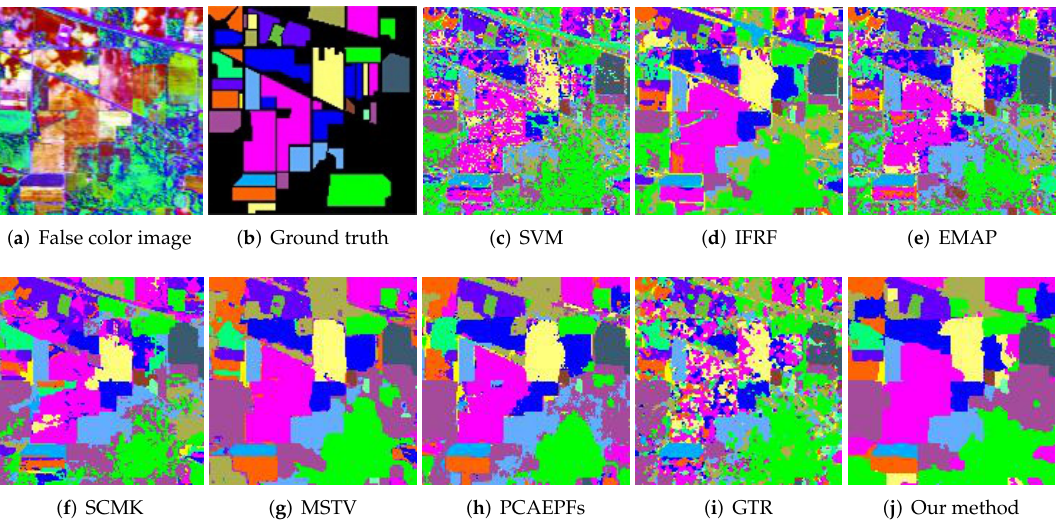
Figure 5. Classification results of all considered approaches on Indian Pines dataset. ( a ) False color image. ( b ) Ground truth. ( c ) SVM [33], OA = 55.30%. ( d ) IFRF [14], OA = 70.09%. ( e ) EMAP [13], OA = 67.70%. ( f ) SCMK [39], OA = 71.20%. ( g ) MSTV [15], OA = 88.25%. ( h ) PCAEPFs [8], OA = 85.58%. ( i ) GTR [40], OA = 63.25%. ( j ) Our method, OA =